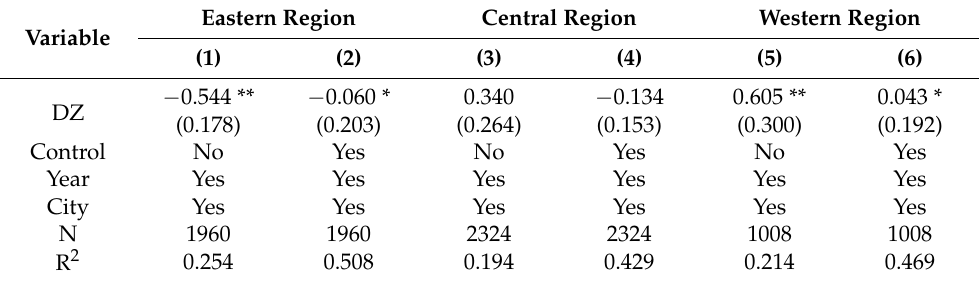
Table 6. Regional regression of the impact of DZs on land urbanization.